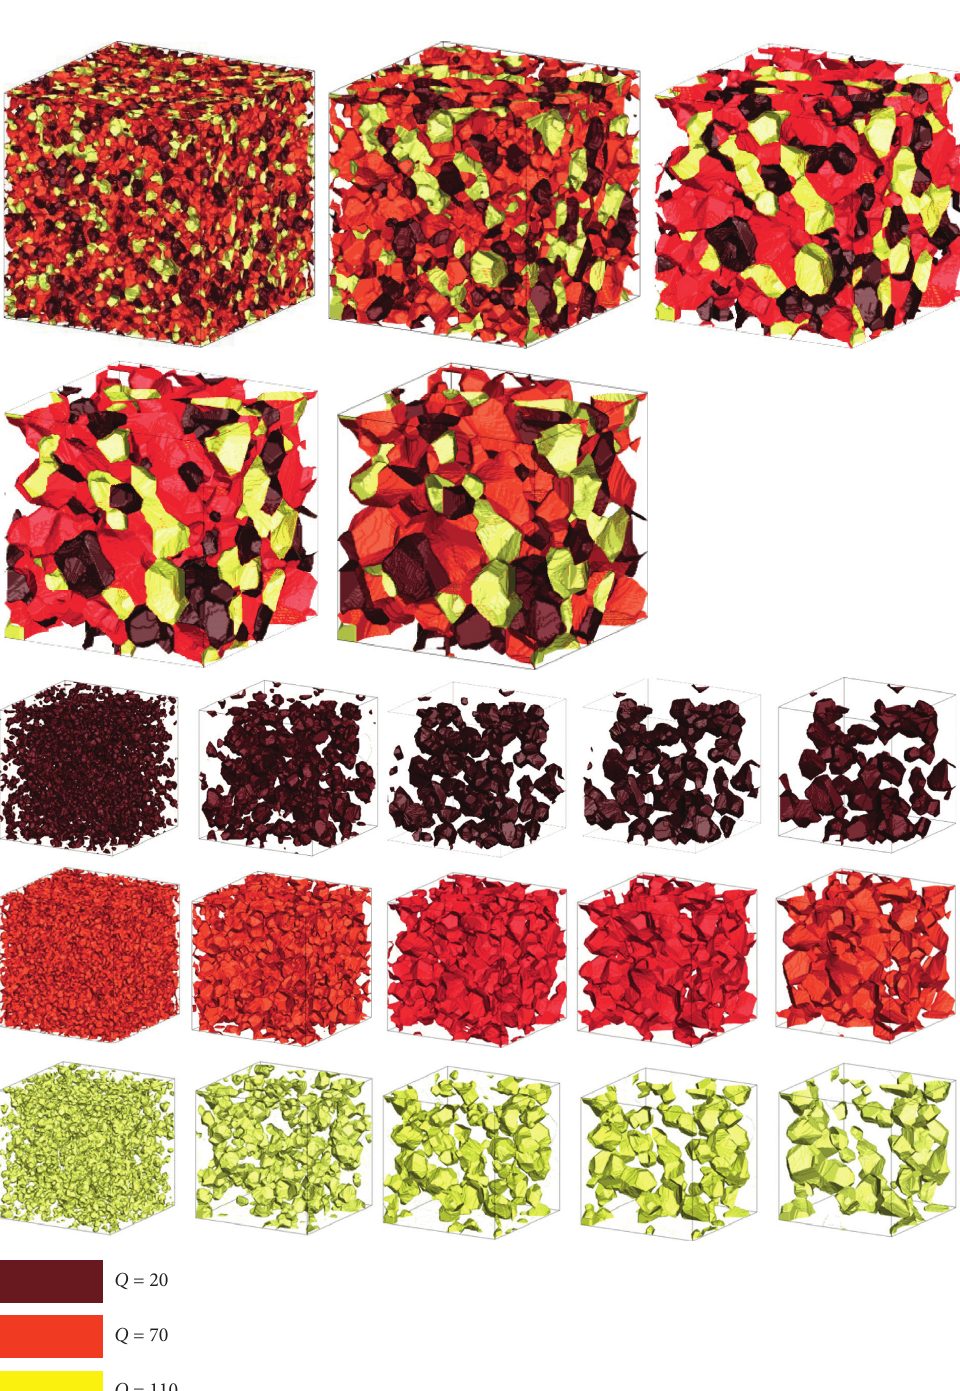
Figure 5: Grain growth with different orientation number at 420 ° C: Q � 20, Q � 70, and Q �